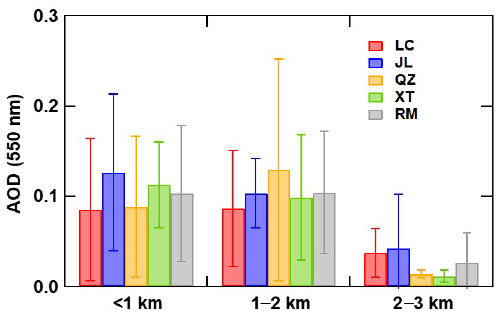
Figure 5. Mean AOD at 550nm at LC, JL, QZ, and XT, and overall mean AOD (RM) at 550nm for different altitude ranges (<1, 1–2, and 2–3km). Standard deviations are also